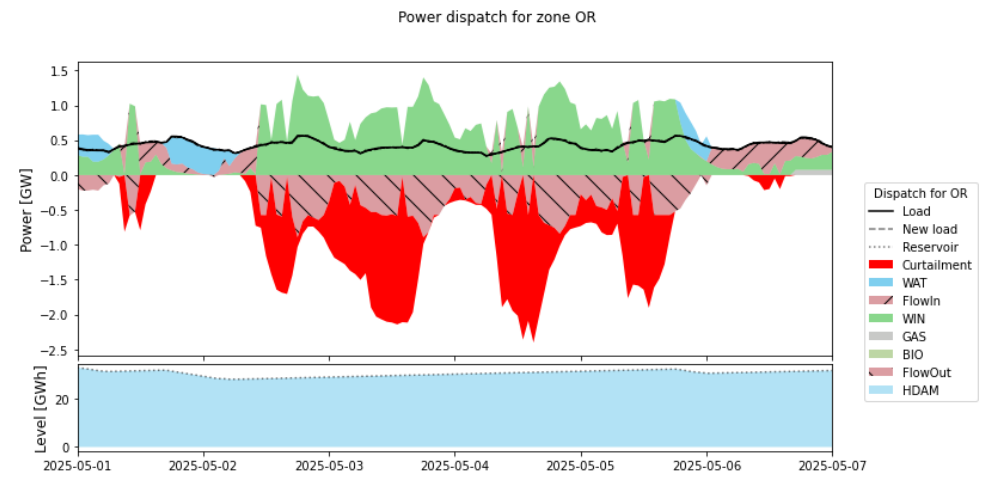
Figure 24. Very-High-Penetration Scenario 10(H)—Oriental zone (1–7 May 2025).